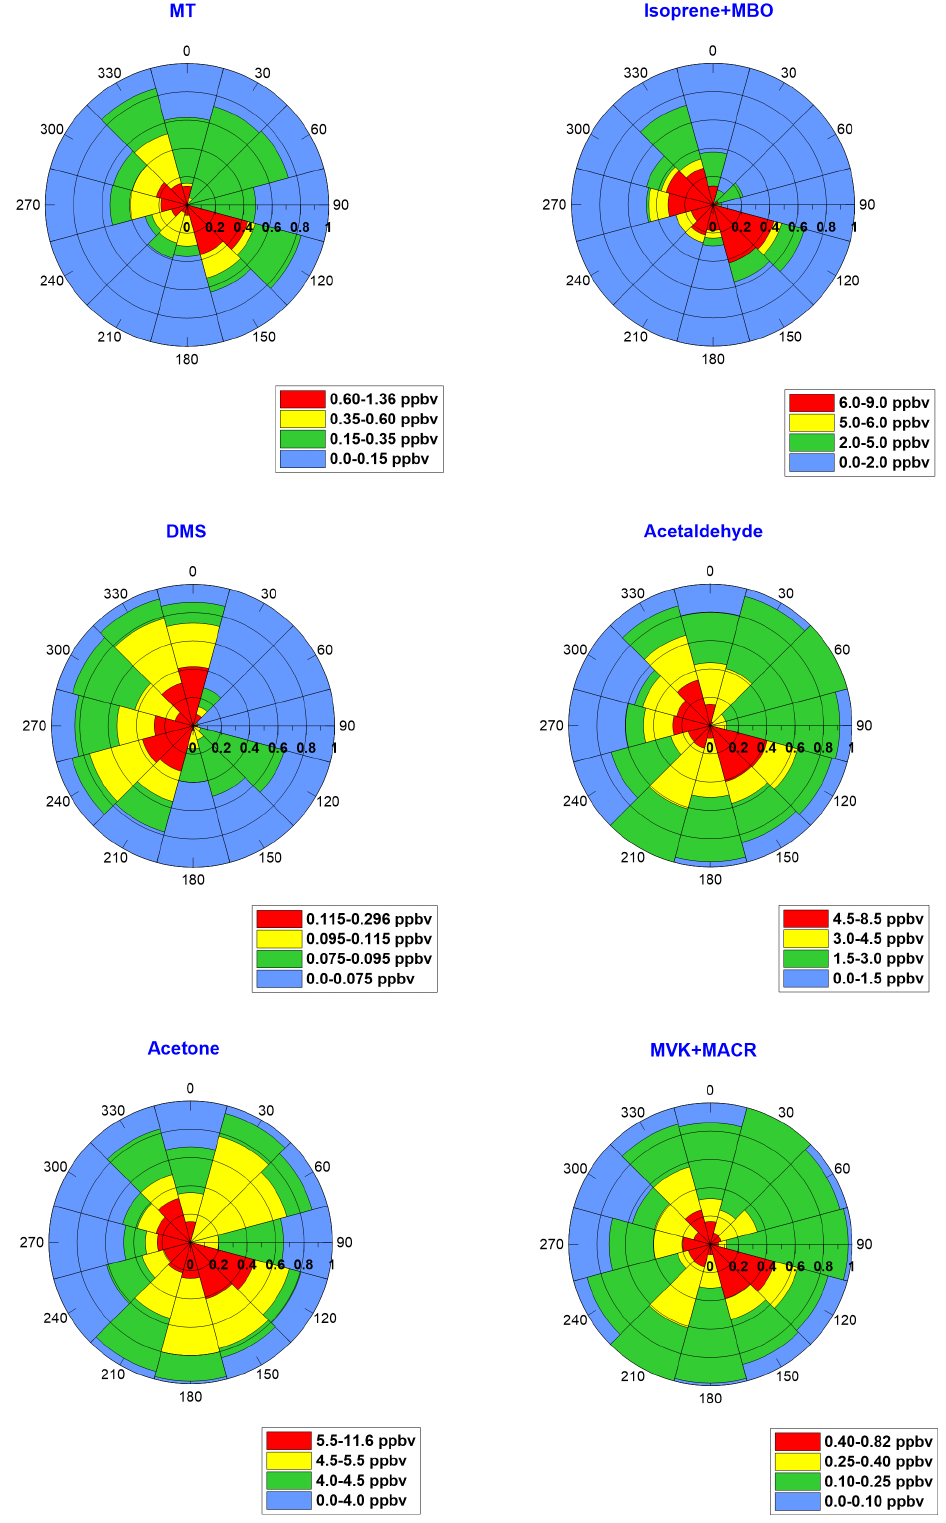
Figure 3. BVOC mixing ratios as a function of the contribution from each wind sector during the daytime. The radial dimension represents the fraction of time for each wind sector during which the mixing ratios were within a certain range, as specified in the color